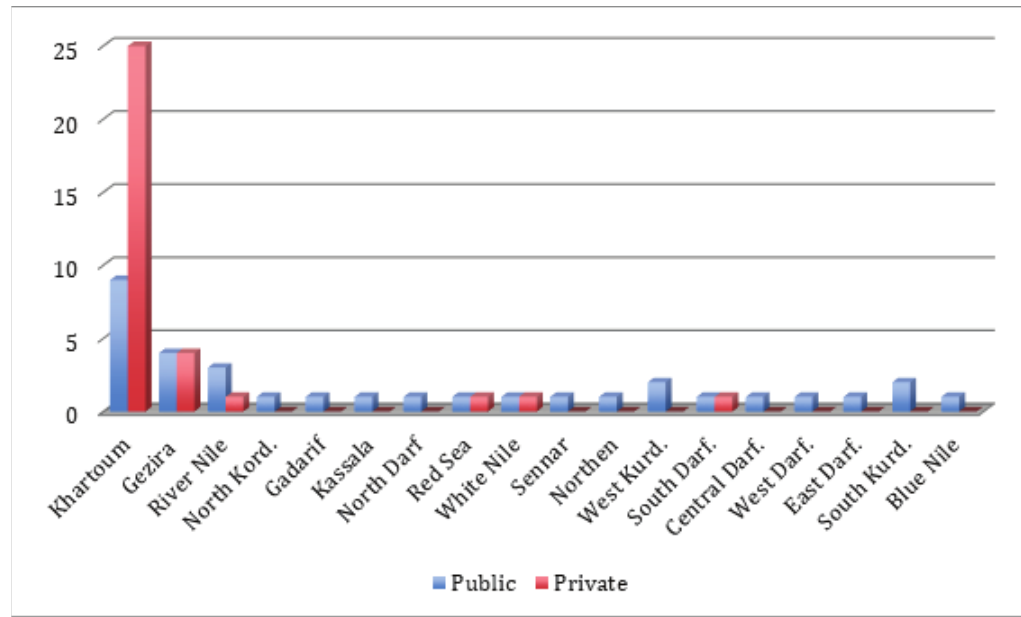
Figure 2: The distribution of the medical school according to Sudan